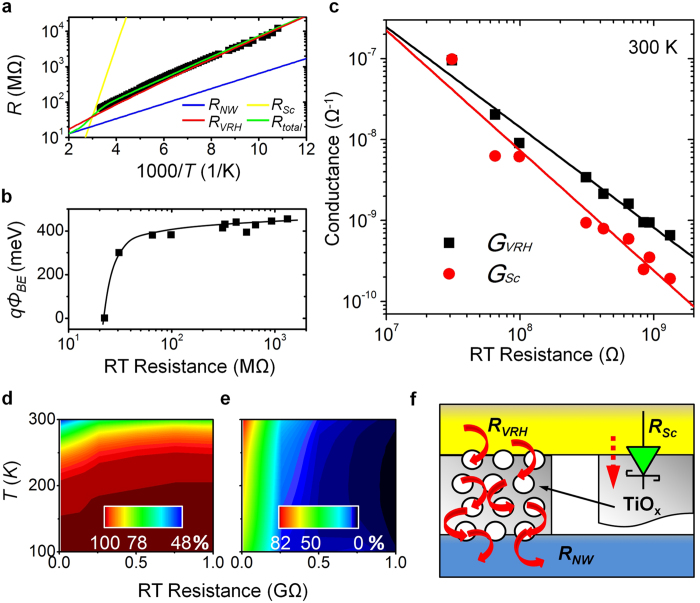
(a) Resistance as a function of inverse temperature for NW5 (65 MΩ at RT) with the best fit of Rtotal(T) in green. RNW(T), RSc(T), and RVHR(T) are the fitting results of the intrinsic NW, the Schottky contact and the Mott’s VRH resistances, respectively. (b) Effective Schottky barrier height (qΦBE) as a function of the RT device resistance; the solid line is a guide for the eye. (c) The contribution of the two NC conductances, GSc and GVRH, at RT as a function of the RT device resistance, where the conductance is a reciprocal value of the resistance. The solid lines are guides for the eye. (d) Map of contribution ratio of the Mott’s VRH conductance (GVRH/(GSc + GVRH)) as a function of temperature and the device RT resistance. (e) Map of contribution ratio of the intrinsic InP NW resistance (RNW/Rtotal) as a function of temperature and the RT device resistance. (f) Schematic of the two NC resistances, RVRH and RSc. The yellow, gray, white, and blue colors denote Au, TiOx, Ti, and InP materials, respectively.